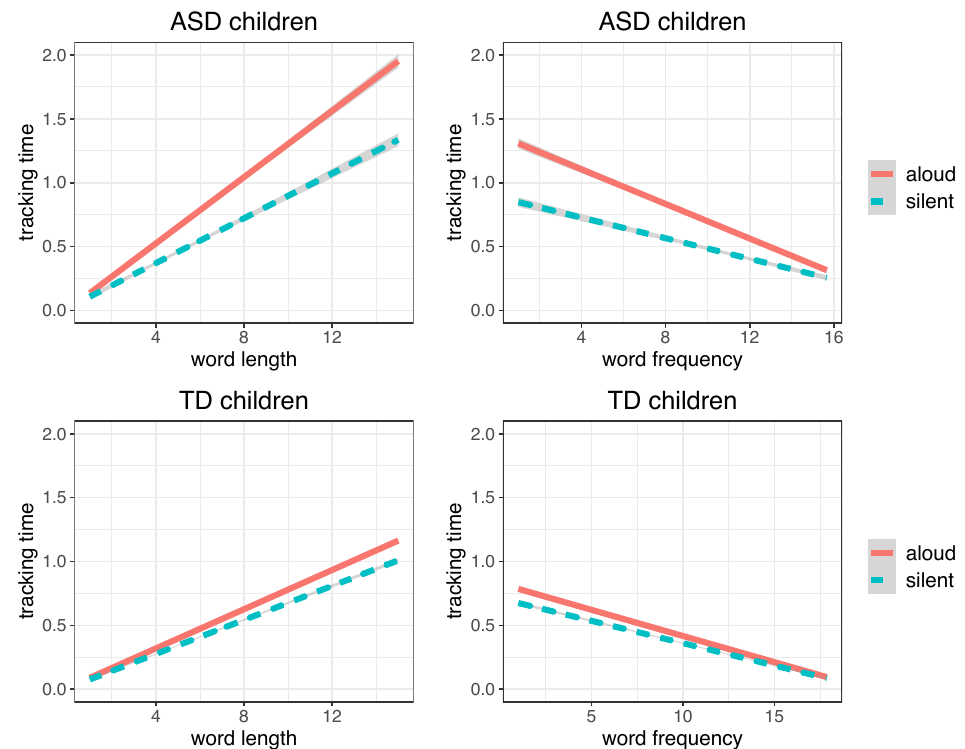
Figure 2. Linear regression plots for word length and word frequency in ASD ( top ) and TD children ( bottom ) in the aloud and silent reading modalities, fitting word tracking time (in seconds) (plot obtained with the ggplot2 package, function lm ; shaded areas indicate 95% confidence interval).